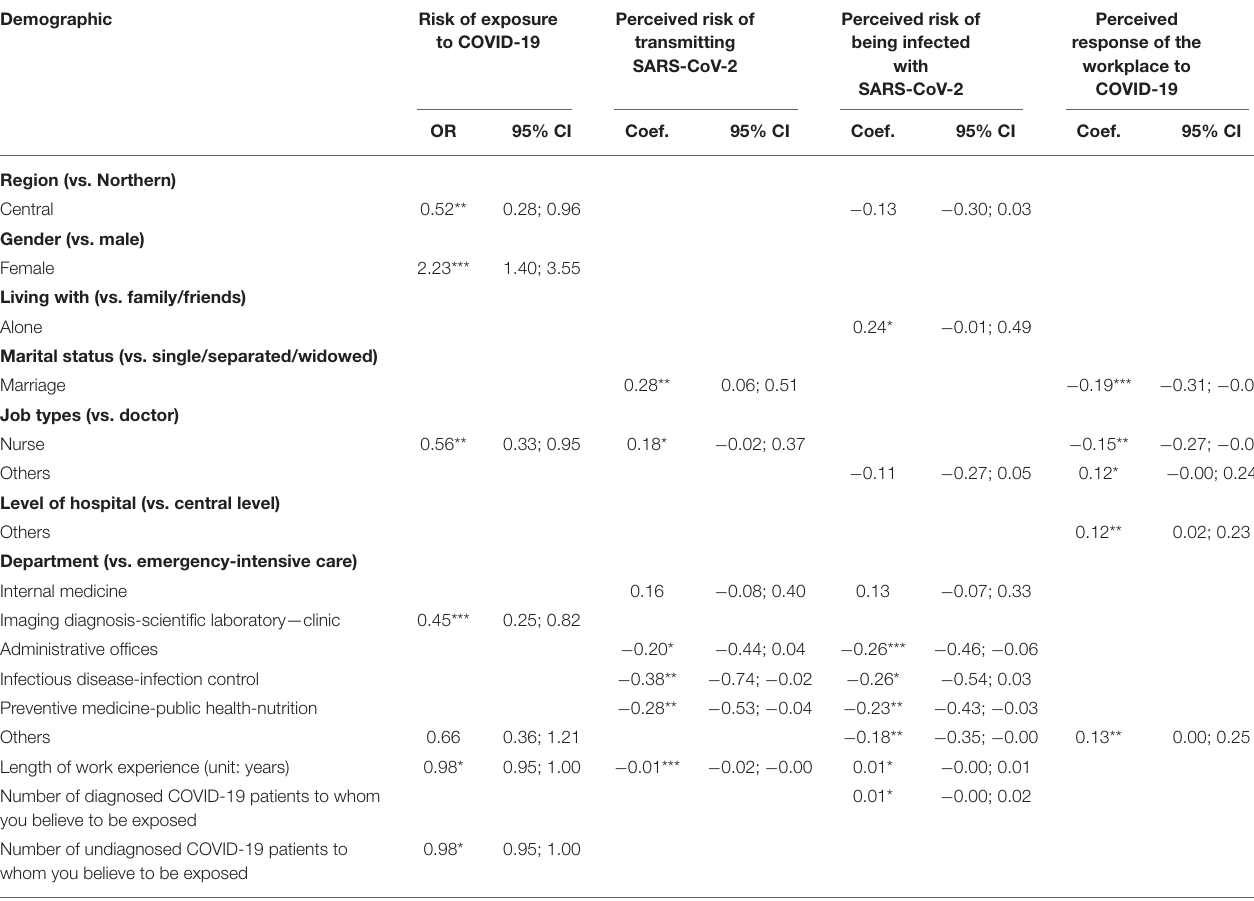
TABLE 4 | Associated factors of exposure risk to COVID-19.